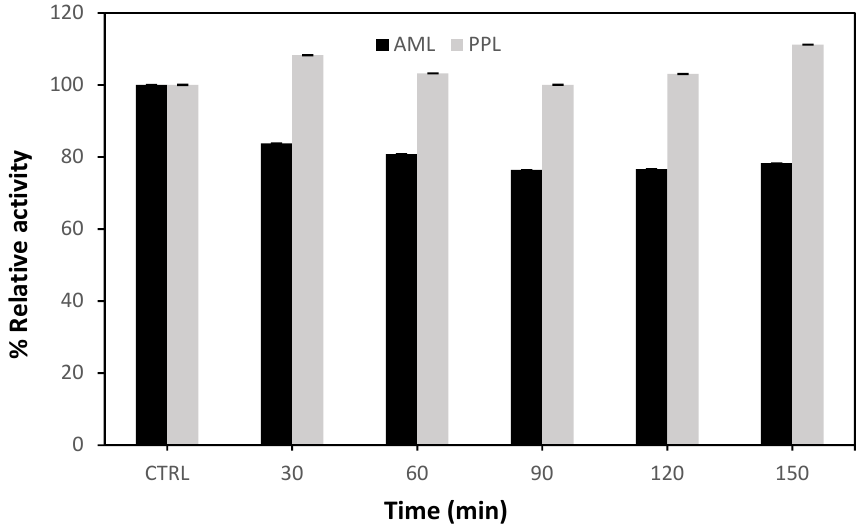
Figure 5. Impact of carbonization time on the relative activity of two types of immobilized lipase, Amano enzyme (AML) and porcine enzyme (PPL), against the free lipases (carbonization Temper- ature 600 °C and impregnation ratio 1.5).